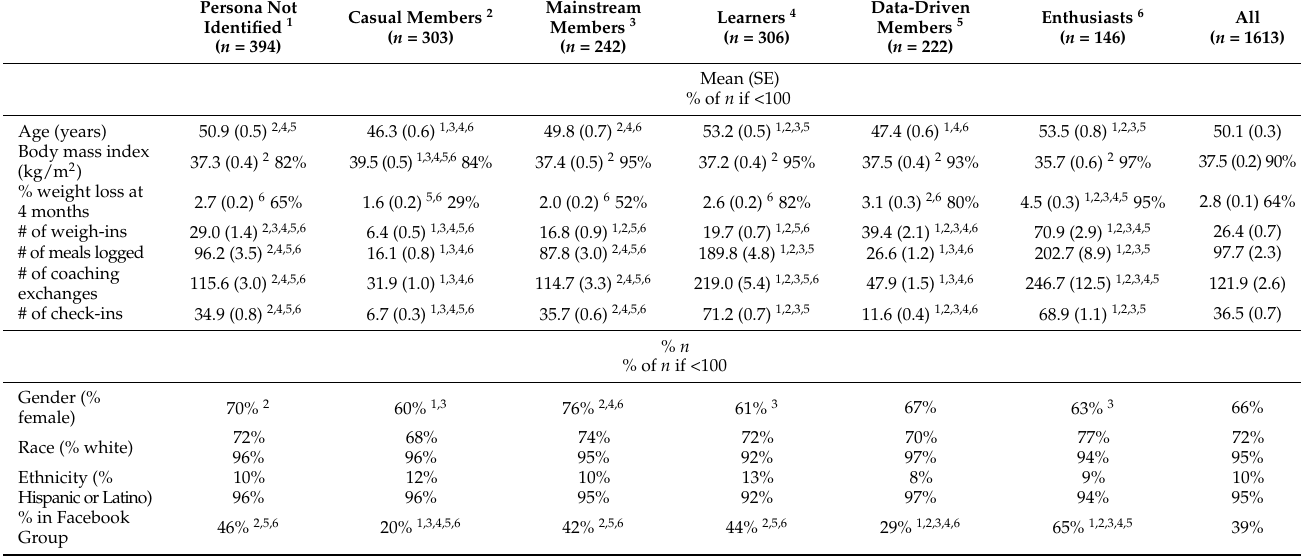
Table 2. Comparisons of engagement personas on participant demographics, characteristics, weight loss, and engagement metrics across 90